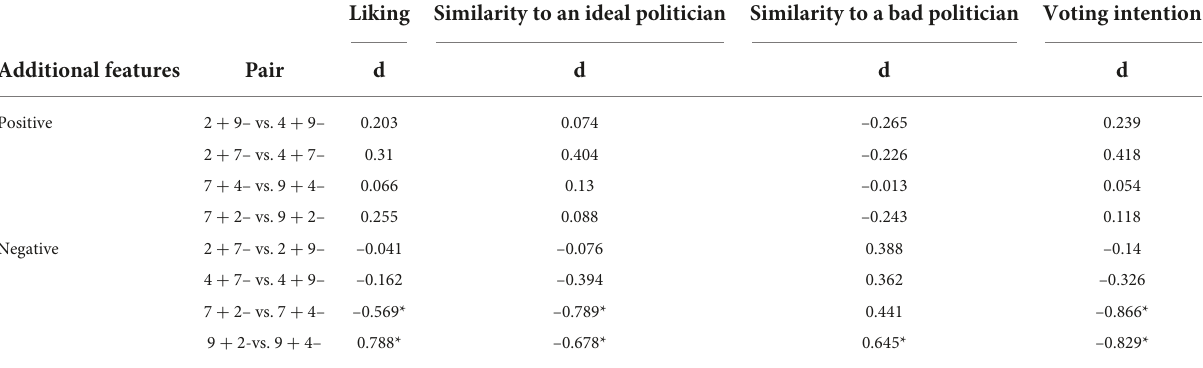
TABLE 4 Effect sizes for the effect of additional positive and negative information items for candidate pairs analyzed in study 3. Liking Similarity to an ideal politician Similarity to a bad politician Voting